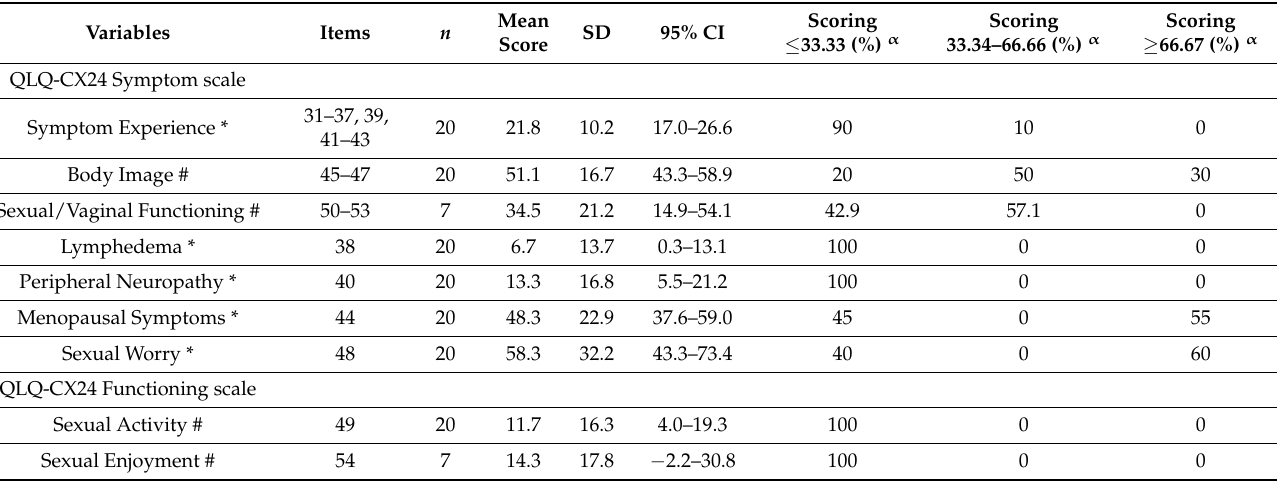
Table 2. The QoL of the